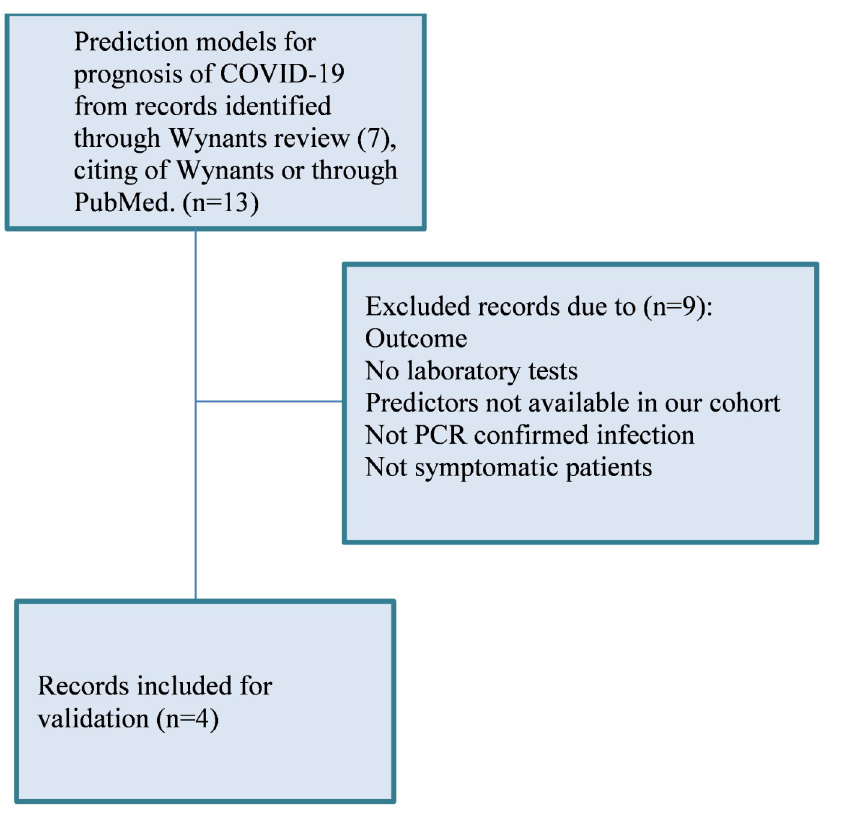
Fig 1. Selection of prediction models for validation.